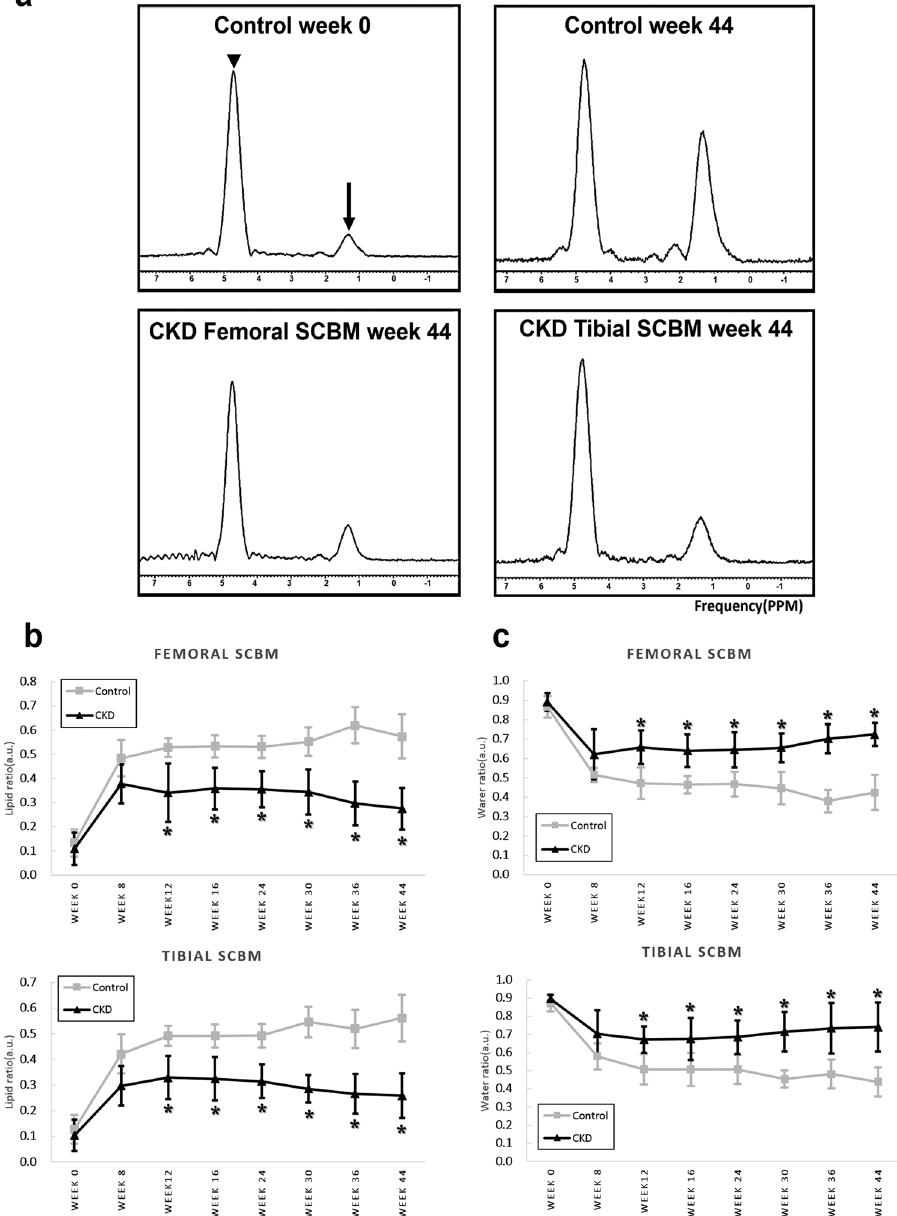
Figure 4. 1 H-MRS spectra of subchondral bone marrow in the control and CKD groups. ( a ) Each spectrum includes a water peak (arrow head) at 4.7 ppm and the lipid peak (arrow) at 1.33 ppm (top row, left). Spectral analysis shows that the lipid peak height increases markedly between 0 and 44 weeks in the control group (top row), but only mildly between 0 and 44 weeks in the CKD group (bottom row). ( b ) Longitudinal MRS study found that the course of change in femoral and tibial SCBM fat-water content differed between the two groups after week 8. Fat content was increased at week 8 and thereafter significantly decreased in the CKD group, while water content is significantly increased in the CKD group after week